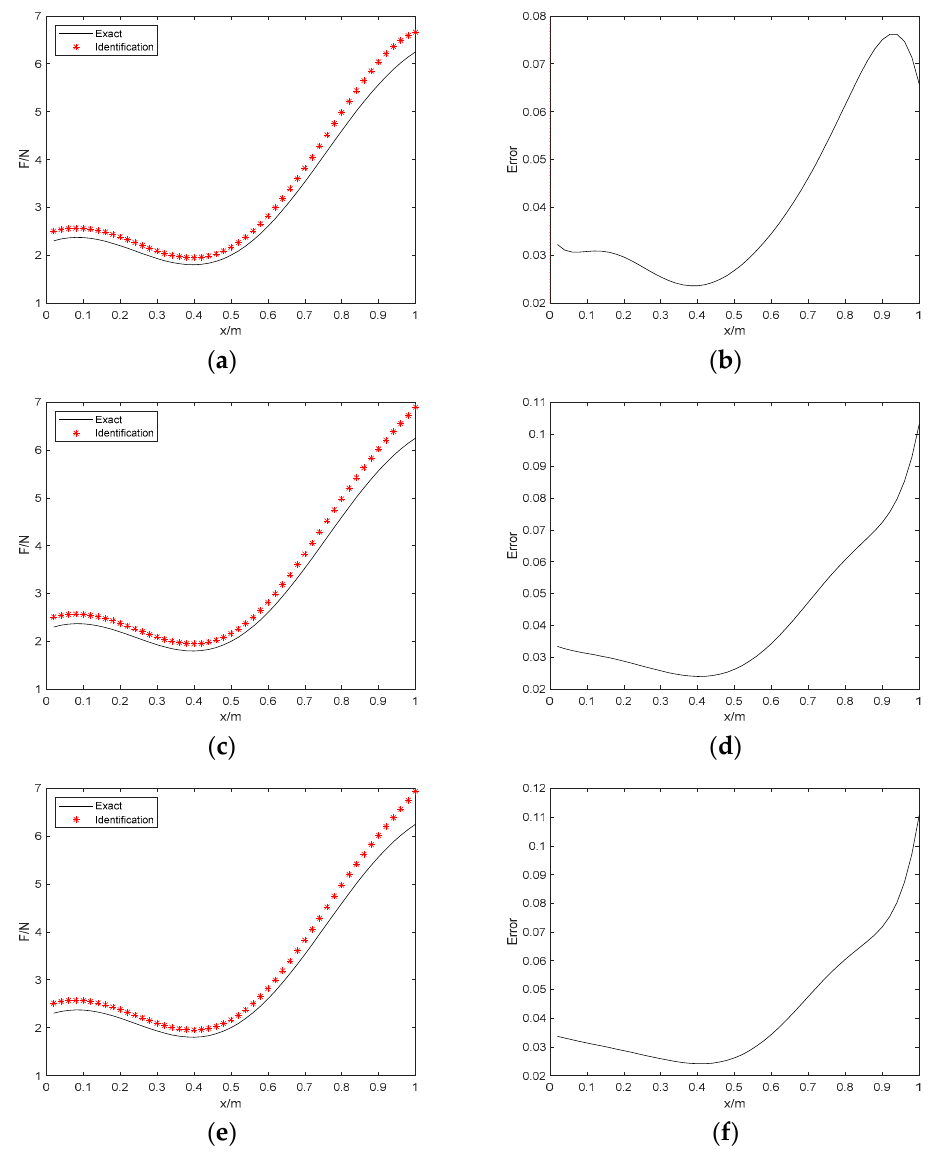
Figure 5. The identification results with 10% noise. ( a ) Proposed method; ( b ) identification error; ( c ) Tikhonov with L − curve regularization; ( d ) identification error; ( e ) Tikhonov with GCV regulariza- tion; ( f ) identification error.